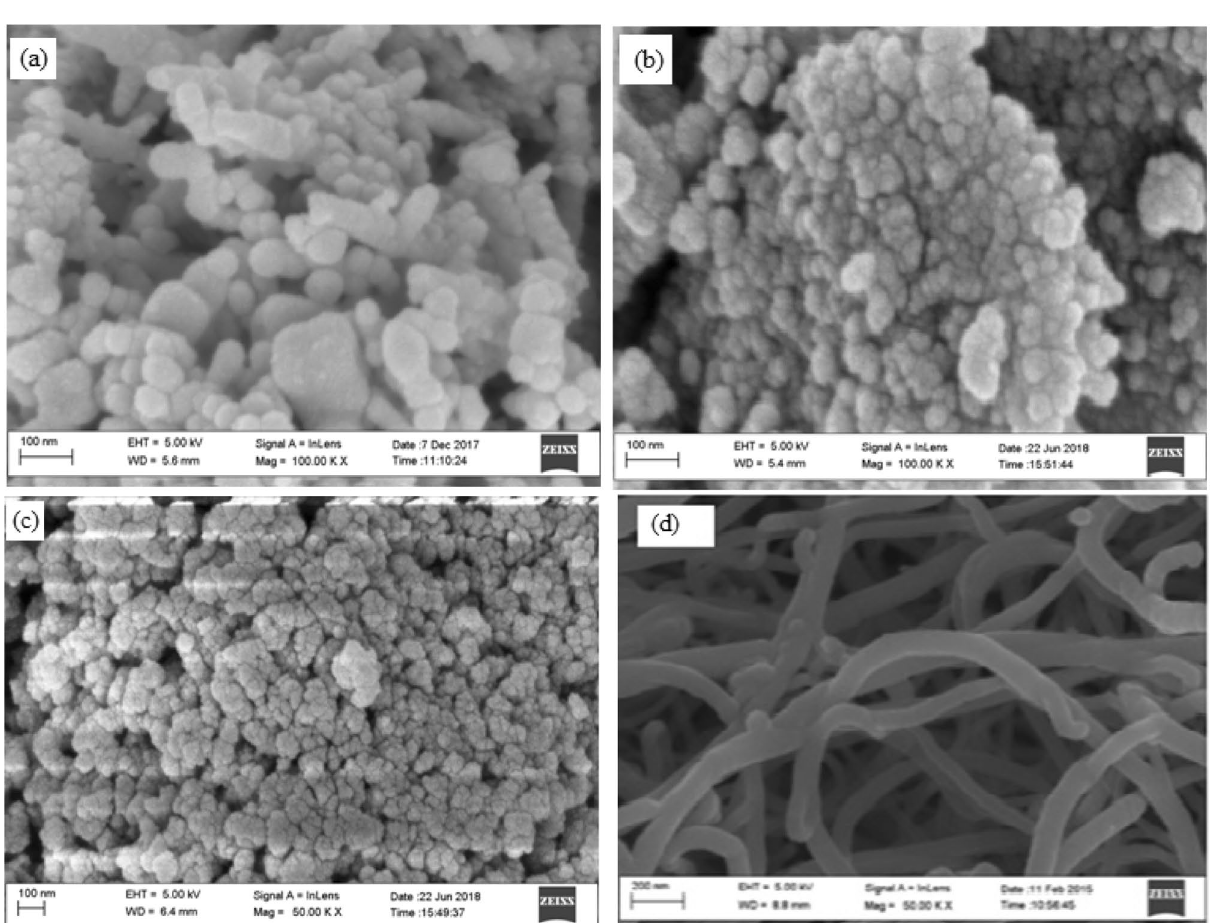
Figure 2. SEM micrographs of ( a ) silver NPs, ( b ) cobalt oxide NPs, ( c ) titanium dioxide NPs and ( d ) purified carbon nanotubes